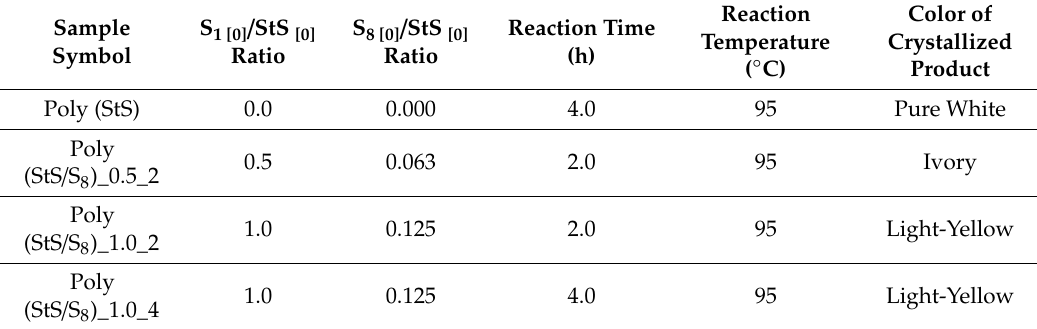
Table 1. Composition of poly (StS) and StS / S 8 copolymers as well as the (co) polymerization process